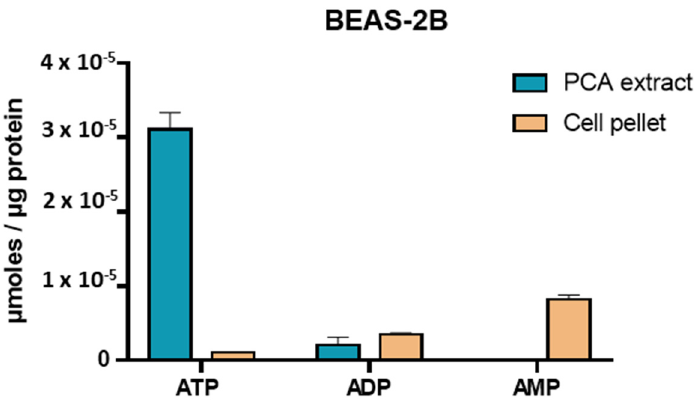
Figure 2. ATP, ADP, and AMP levels ( μ mol/ μ g protein) in BEAS ‐ 2B cells ( n = 4 independent exper ‐